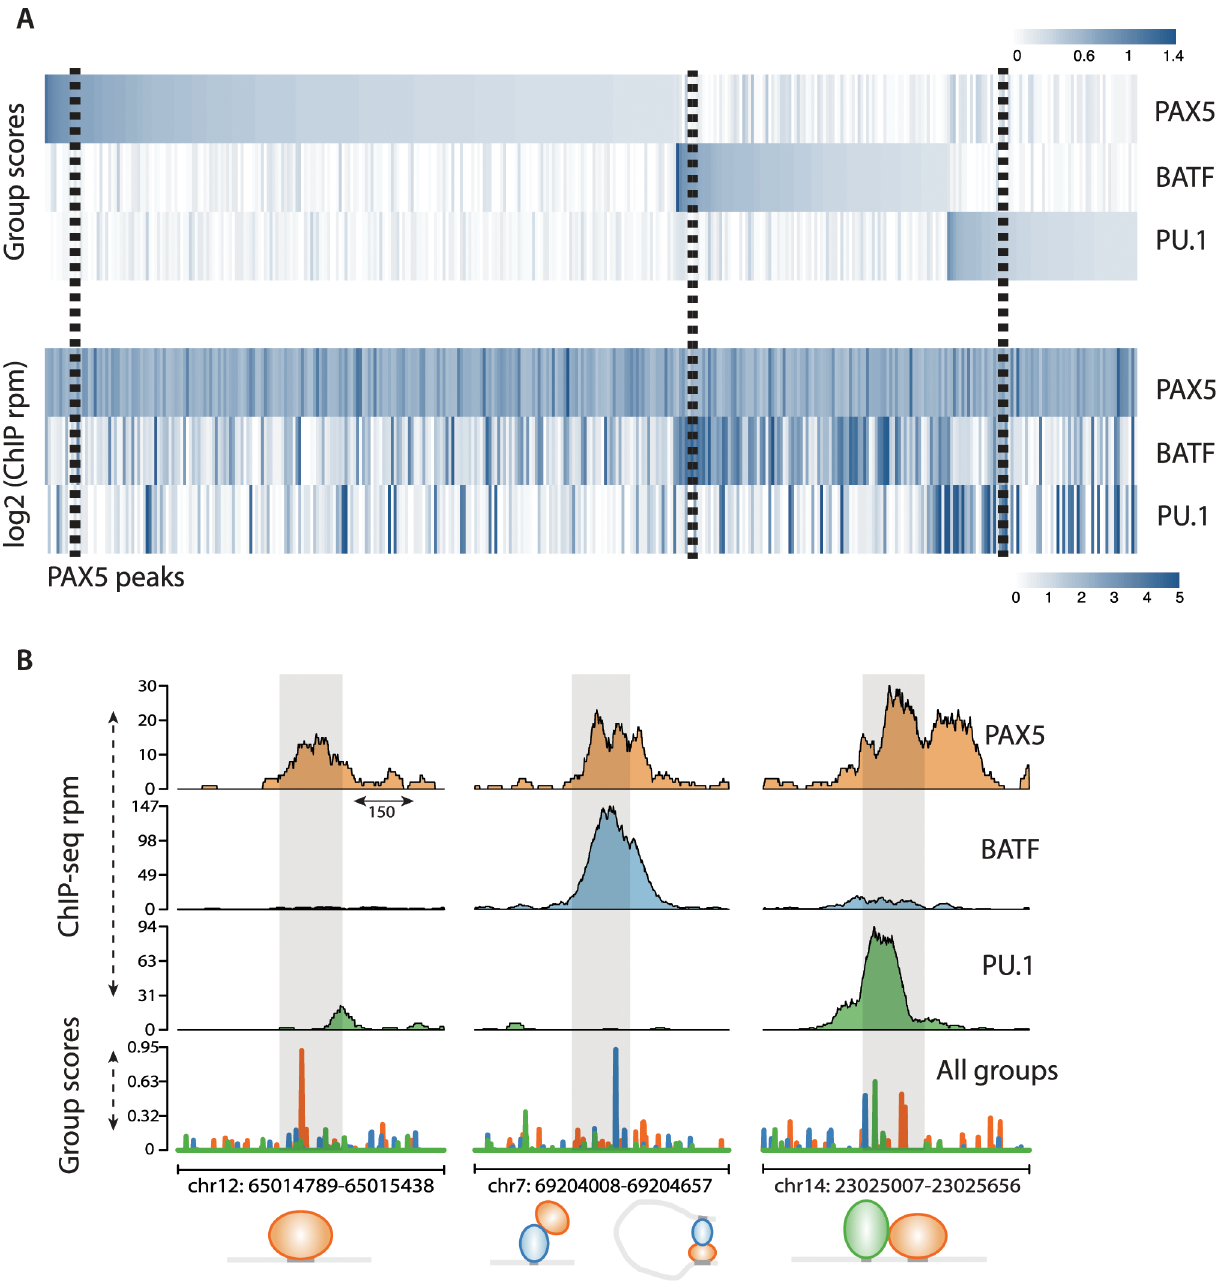
Fig 3. SeqGL identifies binding signals in ChIP-seq occupancy profiles. (A) Heatmaps show predicted binding signals and ChIP occupancy of PAX5 and co-factors. SeqGL analysis of PAX5 ChIP-seq predicts BATF and PU.1 as the most significant binding partners of PAX5. The top panel shows the group scores associated to three TFs from the PAX5 model, and the bottom panel shows the corresponding ChIP-seq read counts. This shows that a number of PAX5 ChIP-seq peaks are indirect and obtained through DNA binding of partners rather than PAX5 itself. The dashed boxes highlight the specific examples illustrated in Fig 3B. (B) Specific examples of PAX5 profiles show various modes of binding detected by SeqGL. The left panel shows direct binding of a TF (PAX5 recognizing its motif). The middle panel shows that the sequence signal is associated to BATF, and hence the PAX5 peak at this location is either due to interaction of the two factors and/or long distance looping. The right panel shows an example of co-binding of PAX5 and PU.1, each recognizing its respective binding motif.